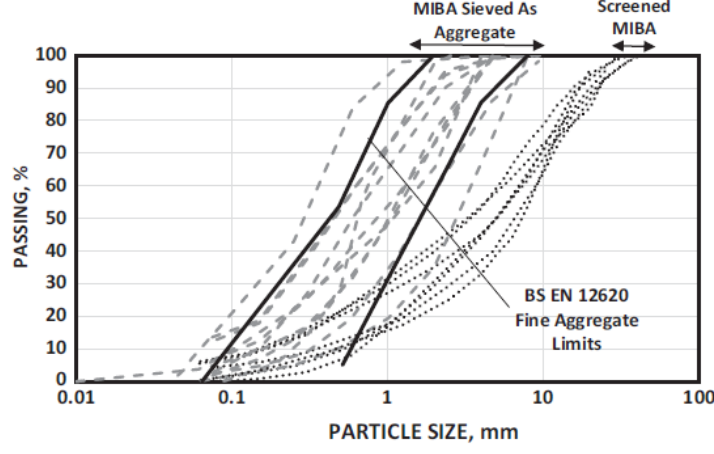
Figure 2. Particle-size distribution of MSWI BA [27].